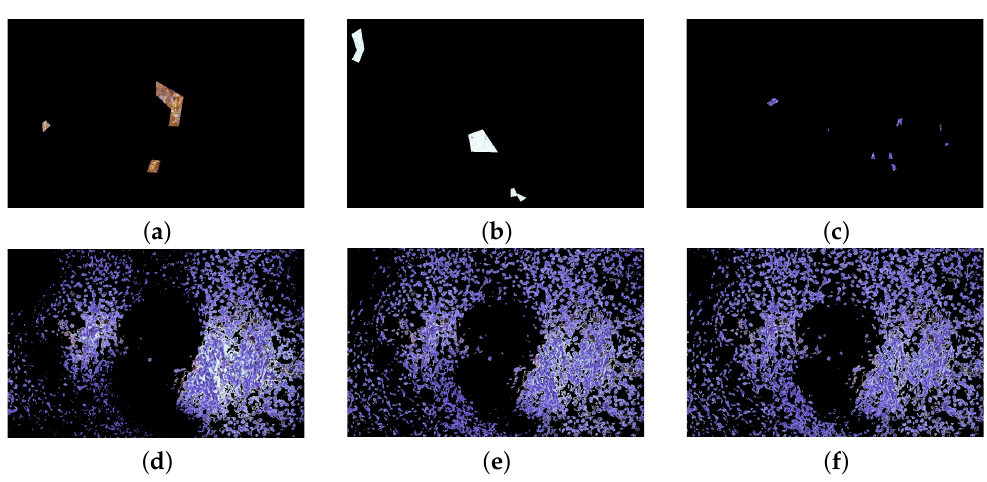
Figure 14. Comparison of the influence of the similarity index regions of the brown part, of white background and blue cells, respectively. ( d ) α = 1, ( e ) α = 2, ( f ) α = 3. The higher the value for α , the more precise the